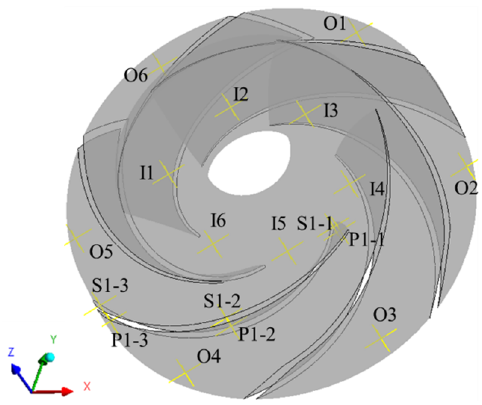
Figure 4. View of setting monitoring points of impeller.